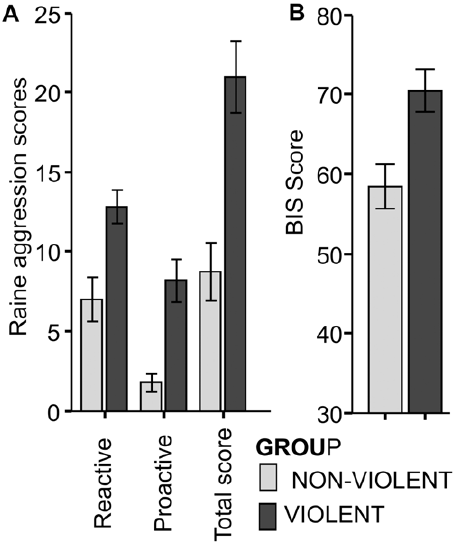
Figure 1. Results of Questionnaires. a) Total aggression score from the Reactive-Proactive- Aggression Questionnaire (RBQ) b) Total scores for impulsivity from the Barratt-Impulsiveness Questionnaire (BIS-11).